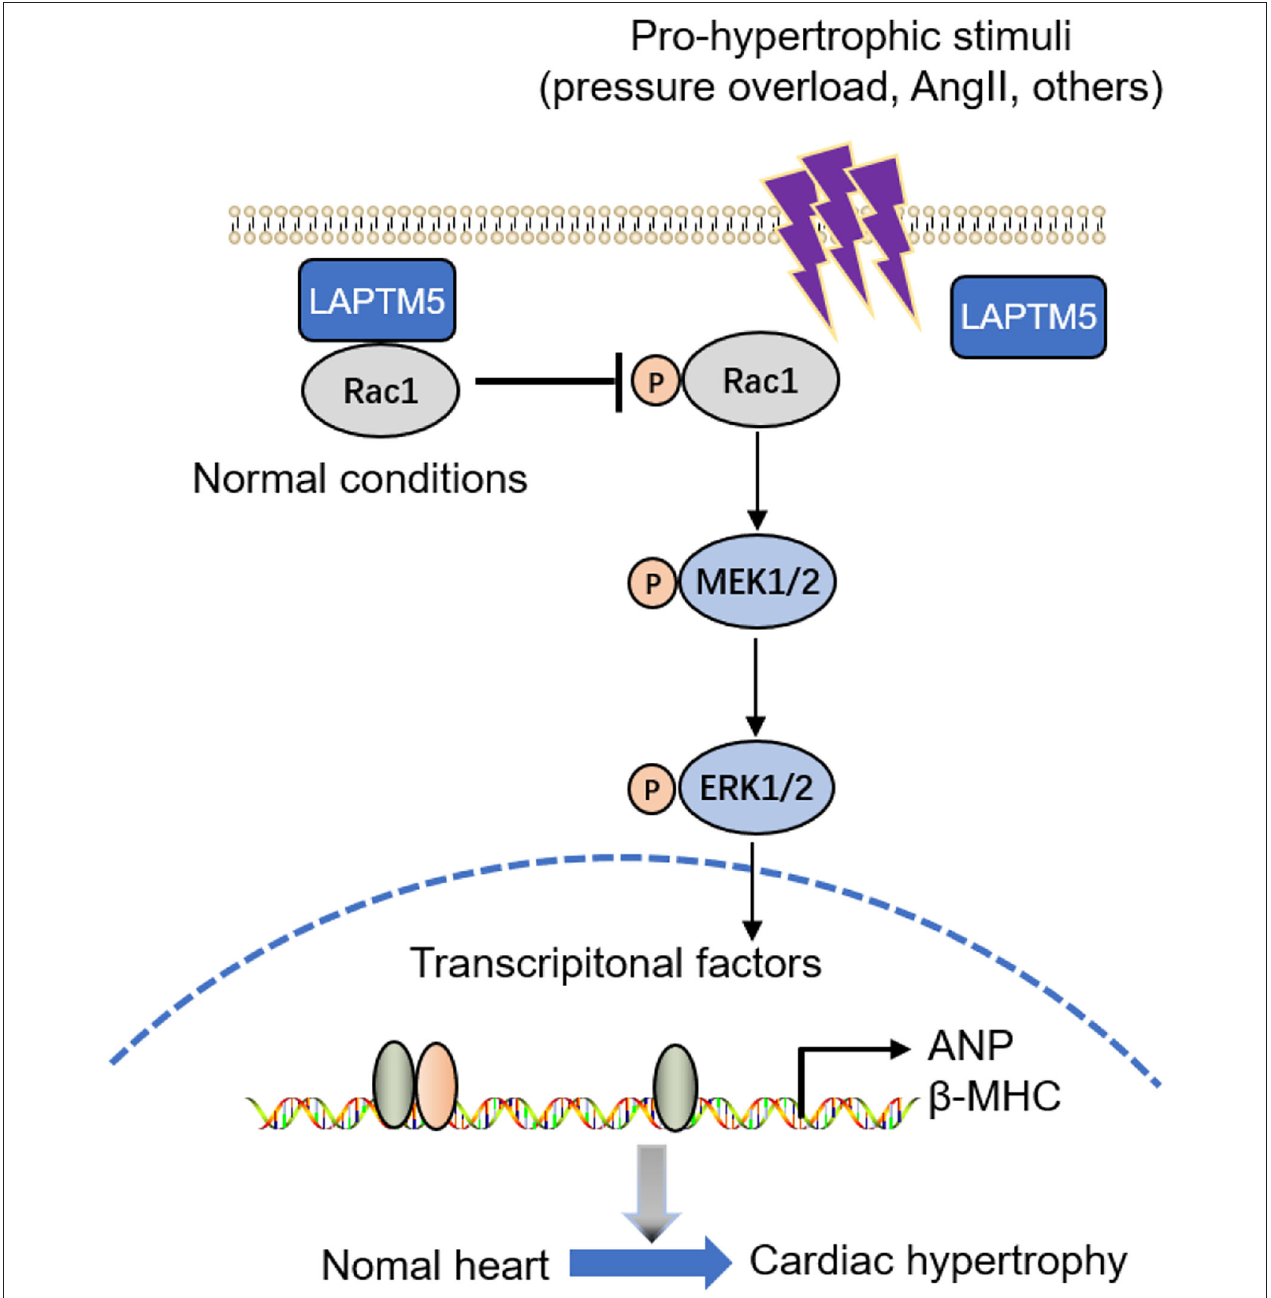
FIGURE 8 | Graphical representation of the role and signaling of LAPTM5 in cardiac hypertrophy. LAPTM5 binds to Rac1, inhibiting cardiac hypertrophy by suppressing the MEK-ERK1/2 pathway.